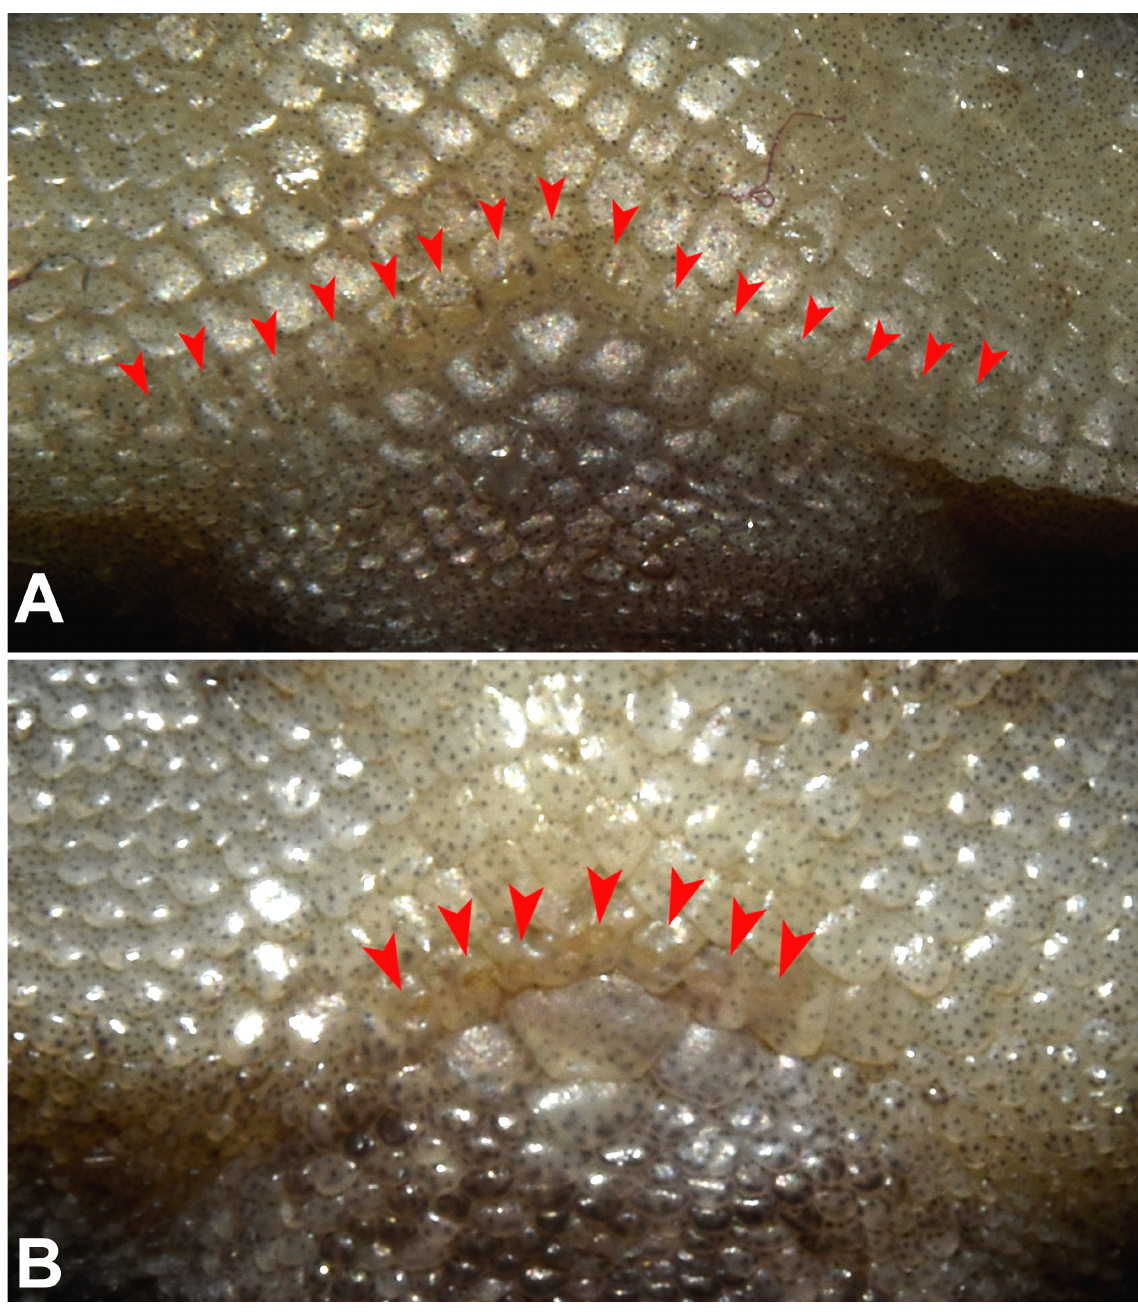
Fig. 5. The arrangement of precloacal pores in A . Cyrtodactylus exercitus sp. nov., holotype (MZMU2542) B . Cyrtodactylus siahaensis sp. nov